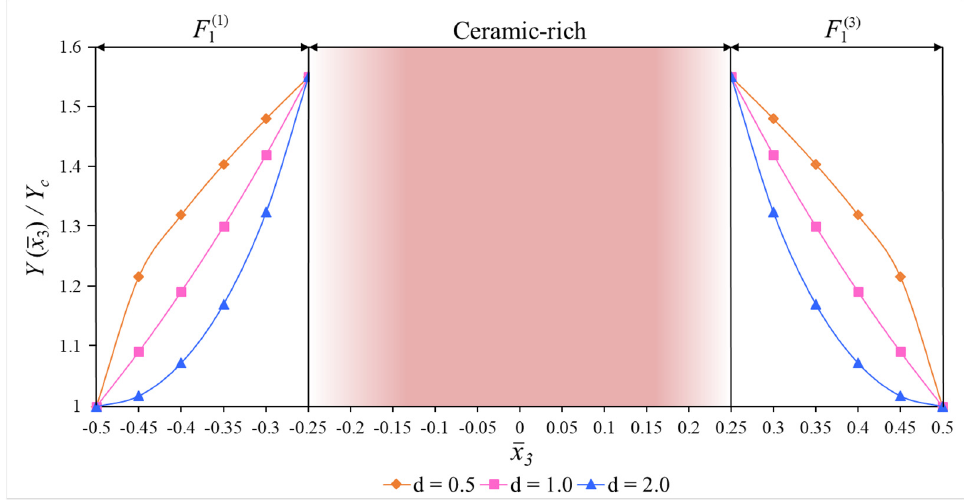
Figure 2. The variations in the dimensionless Young moduli of FG 1 /C/FG 1 cylindrical shells.